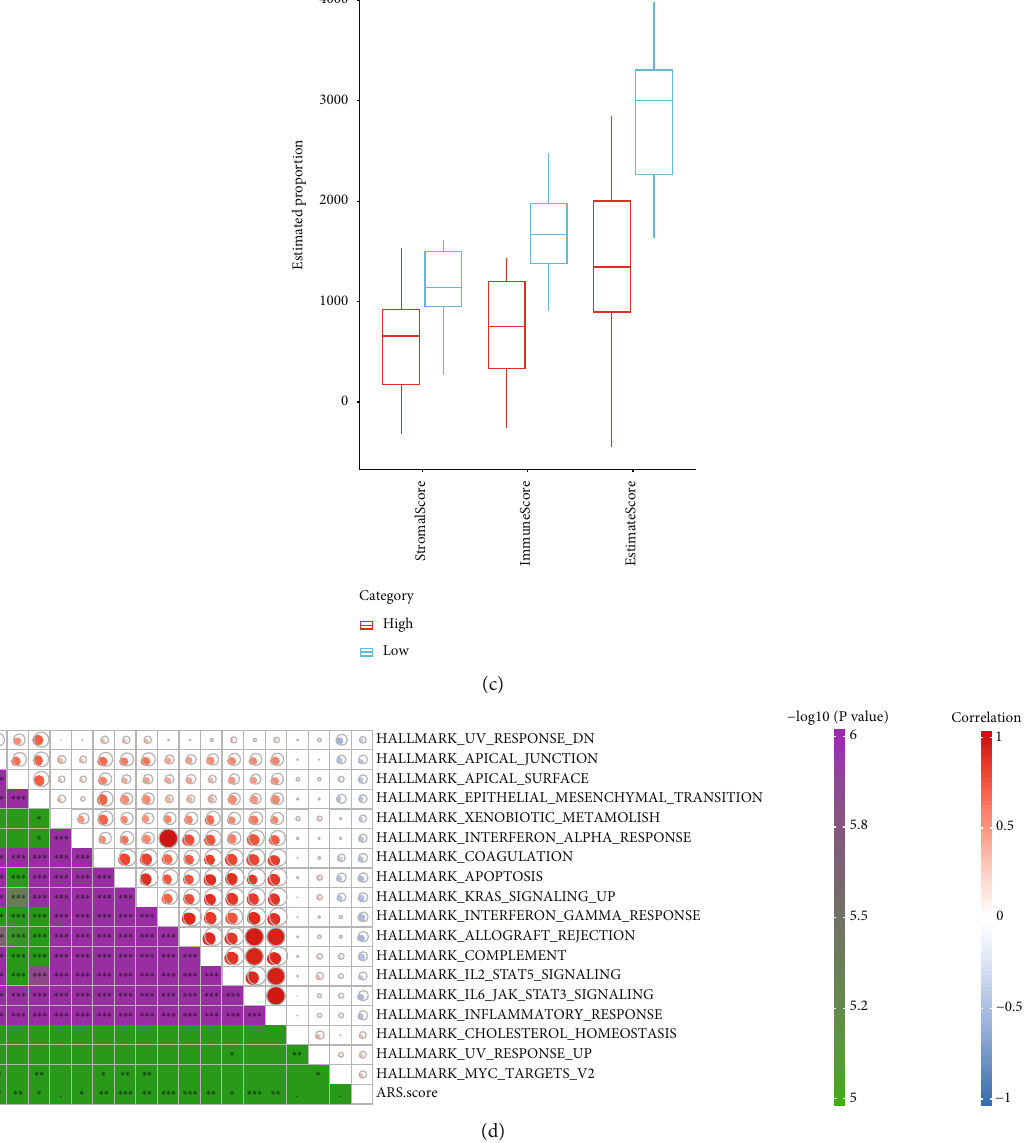
Figure 7: The characteristics of immune and pathway landscape between the high- and low-risk groups in the TCGA cohort. (a) Comparison of in fi ltration level of 64 immune cells in the high- and low-risk groups. (b) Correlation matrix of the risk score and in fi ltration level of immune cells. (c) Comparison of the stromal score, immune score, and ESTIMATE score between the high- and low- risk groups. (d) Correlation network between the enriched pathways and risk score. ns: no signi fi cance. ∗ P < 0 : 05, ∗∗ P < 0 : 01, ∗∗∗ P < 0 : 001,and ∗∗∗∗ P < 0 : 0001